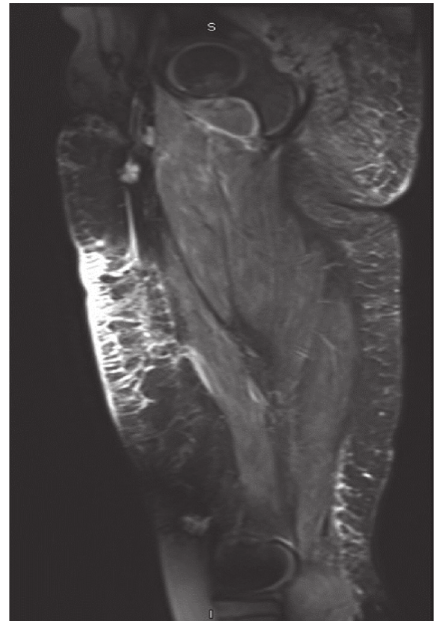
Figure 1: MRI imaging of thigh. Sagittal fat suppressed T2- weighted images revealing muscle edema and calcifications in the fascial